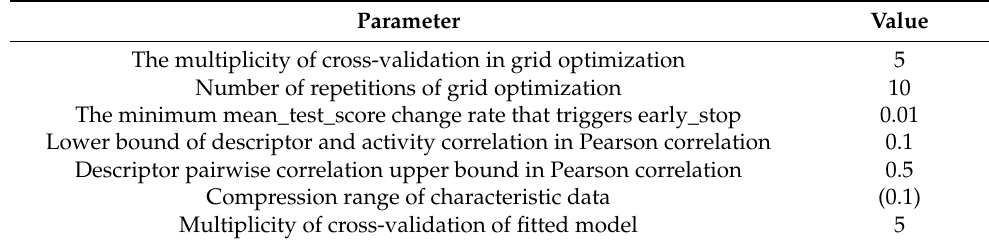
Table 3. Parameters of Grid Search. Parameter Value The multiplicity of cross-validation in grid optimization 5 Number of repetitions of grid optimization 10 The minimum mean_test_score change rate that triggers early_stop 0.01 Lower bound of descriptor and activity correlation in Pearson correlation 0.1 Descriptor pairwise correlation upper bound in Pearson correlation 0.5 Compression range of characteristic data Multiplicity of cross-validation of fitted